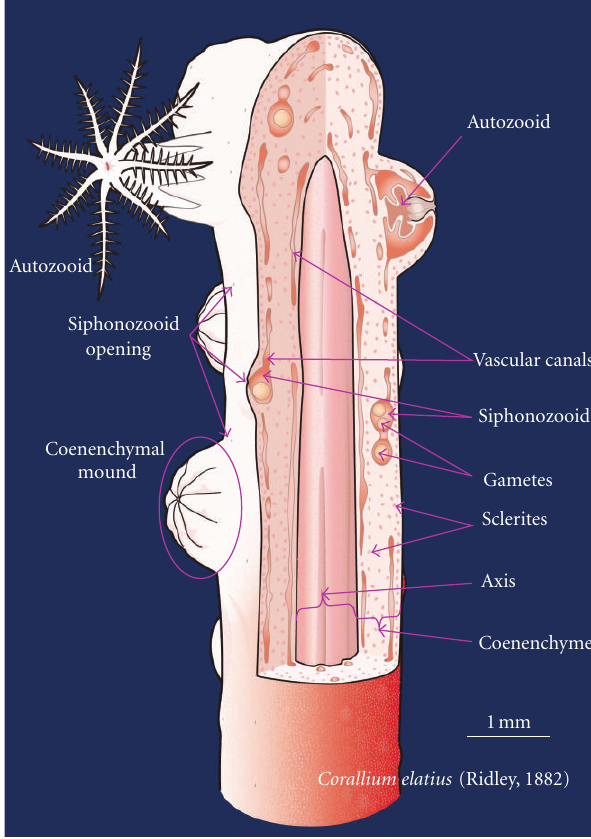
Figure 21: Diagrammatic section through a branchlet of Corallium elatius , showing coenenchyme and axis.